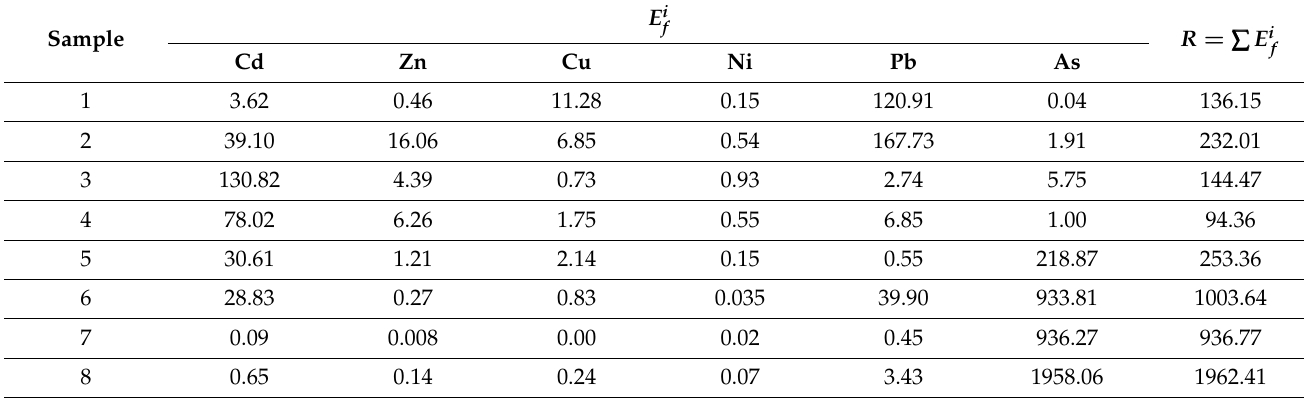
Table 9. Potential ecological risk assessment results of metals in soil